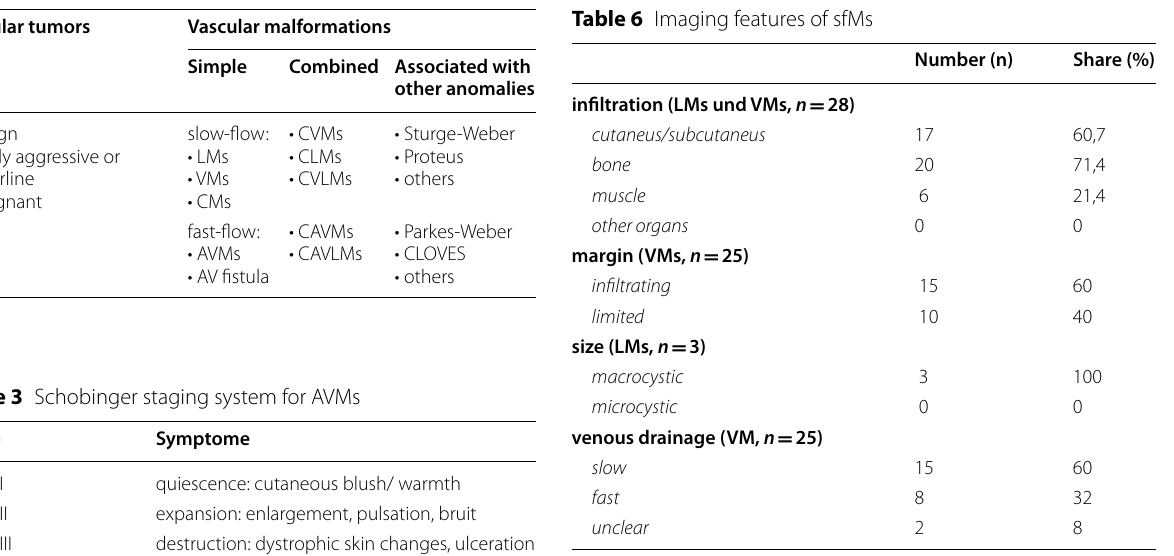
Table 2 ISSVA Classification of vascular anomalies